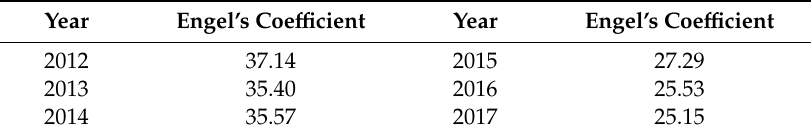
Table 2. Engel’s coefficient of all residential households in E city.